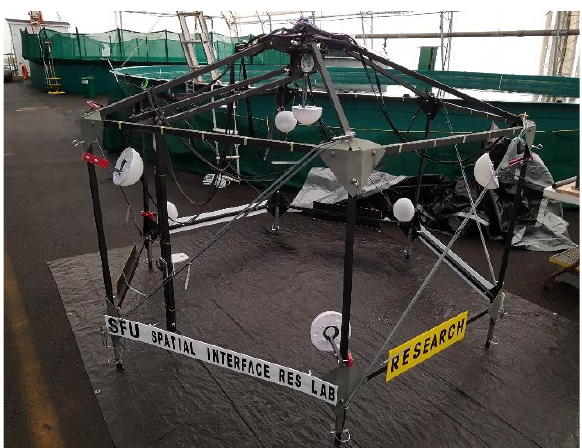
Figure 1. A custom designed data capture platform